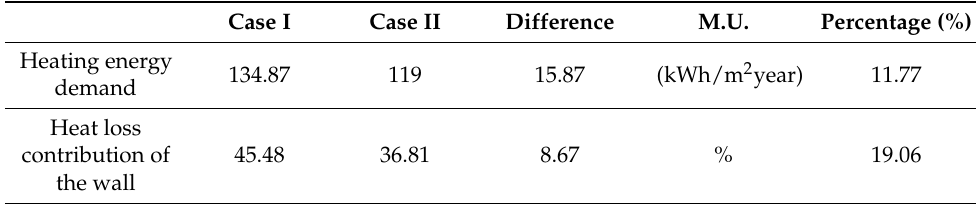
Table 5. Results for the steady-state